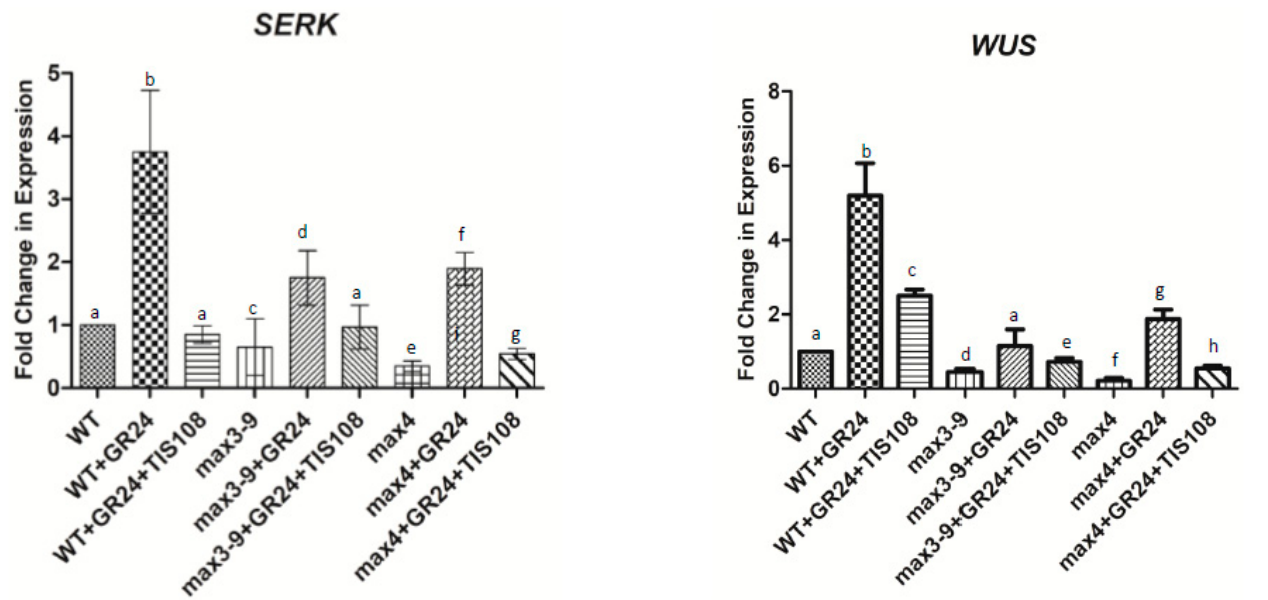
Figure 5. Fold change in expression levels of SERK1 and WUS in WT, max3–9 , and max4 tissue after 7 days of induction. Tissue was also treated with GR24 (50 nM) and/or TIS108 (10 nM). Values are means ± SE of three biological replicates ( n = 15). Letters on bars indicate statistically significant differences ( p < 0.05).